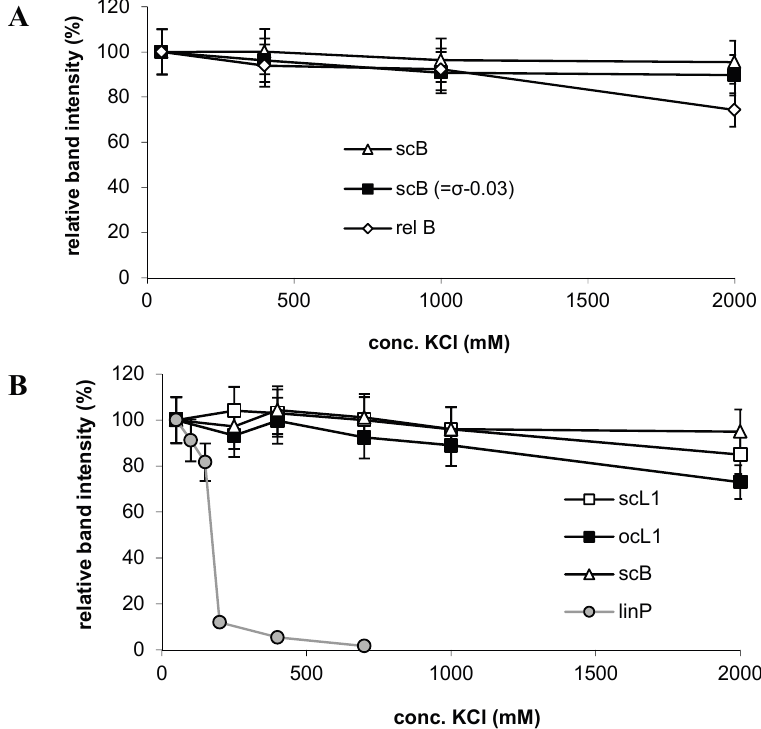
Figure 5 Dependence of relative fractions of DNAs resisting salt treatment on KCl concentration to which the immunoprecipitated (DO-1)-p53-DNA complexes were exposed. Analogous experiments as in Figure 2B with different DNA substrates: ( A ) pBSK plasmid: (rel); and ( B ) sc pL1, native σ (scL1), open circular pL1 (ocL1), sc pBSK, native σ